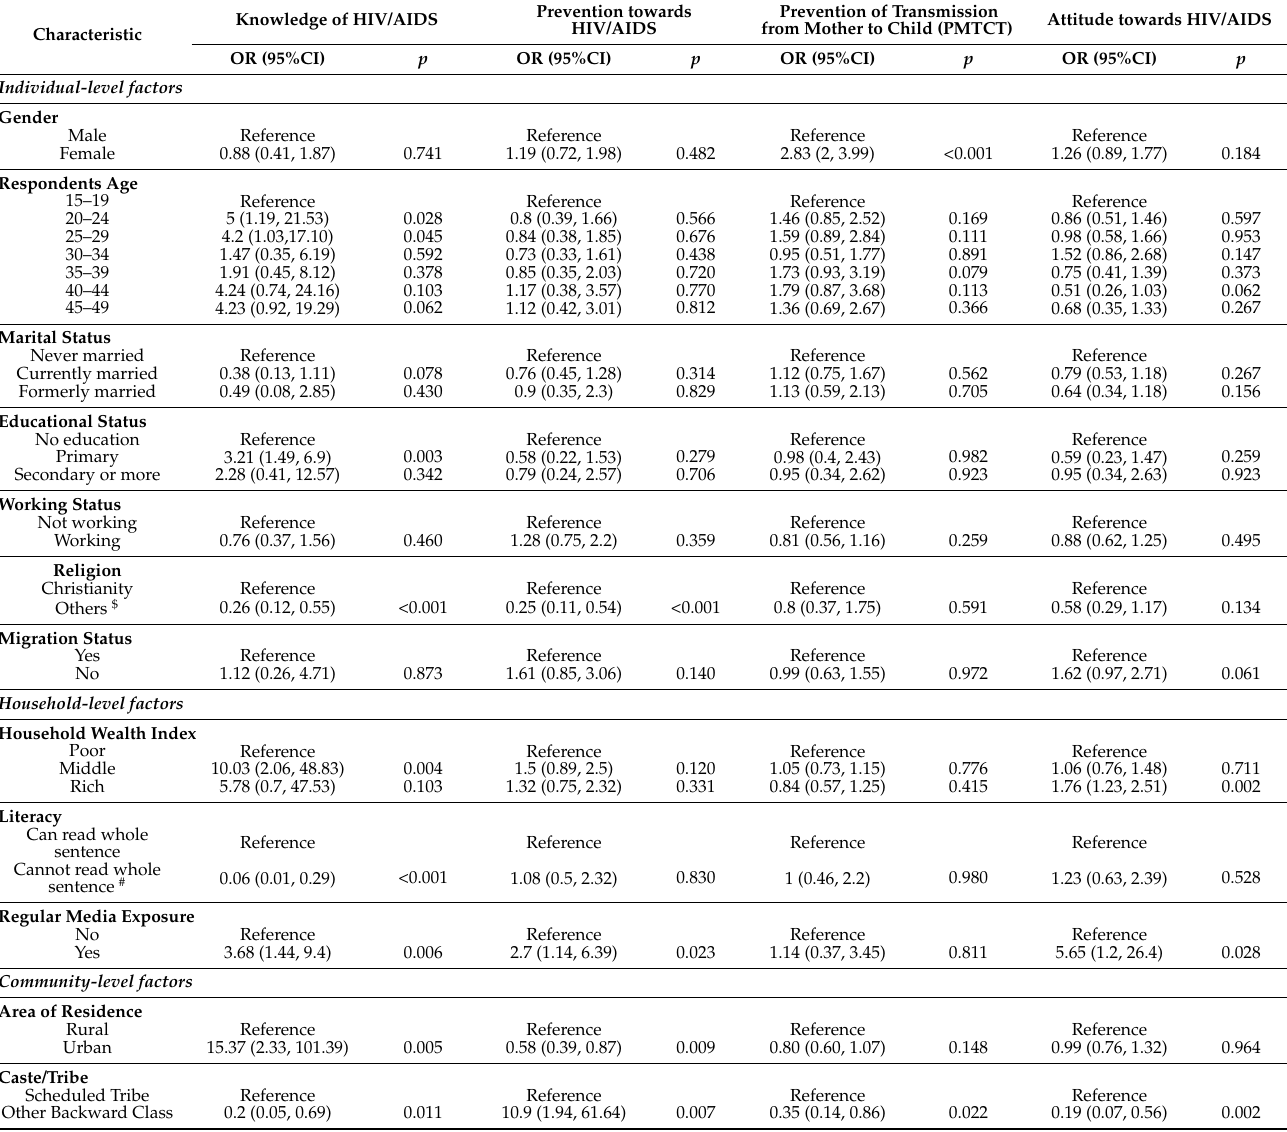
Table 3. Logistic analysis of respondent’s knowledge, attitudes, and prevention towards HIV/AIDS by individual-, household socioeconomic- and community-level